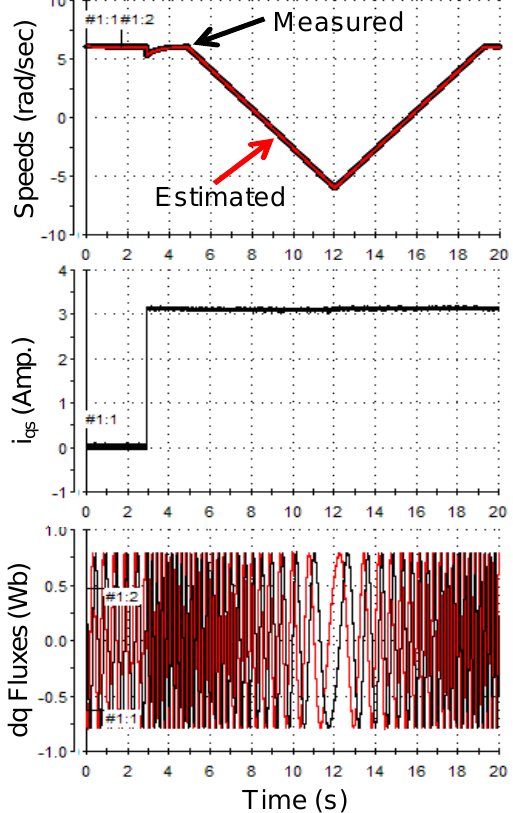
Figure 18. Experimental tests at a speed reference of 0.06 p.u (9.42 rad/s) was changed slowly to − 0.06 p.u ( − 9.42 rad/s) with an applied load torque change of +7 N.m applied at t = 2 s.